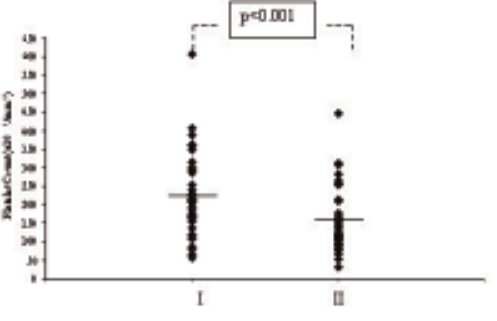
Platelet counts at Intensive Care Unit (ICU) admission (I) and the nadir platelet count associated with Intensive Care Unit acquired pneumonia (ICUAP-platelet count) (II), (Small horizontal lines indi- cate the mean values: 157.2 ± 87.4 (cid:2) 10 3 /mm 3 , 224.1 ± 106.3 (cid:2) 10 3 /mm 3 respectively).